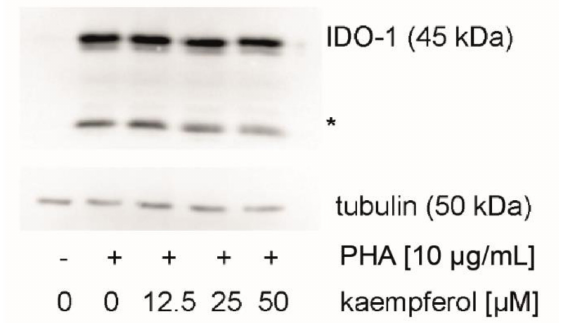
Figure 6. Indoleamine dioxygenase 1 (IDO-1) protein expression was investigated in unstimulated, stimulated, and kaempferol treated peripheral blood mononuclear cells (PBMC). A representative blot is shown, the experiment four times with PBMC obtained from di ff erent donors. An additional signal was observed at 25 kDa (indicated with an asterisk). All blots can be found in the supplement (Figures S2 and